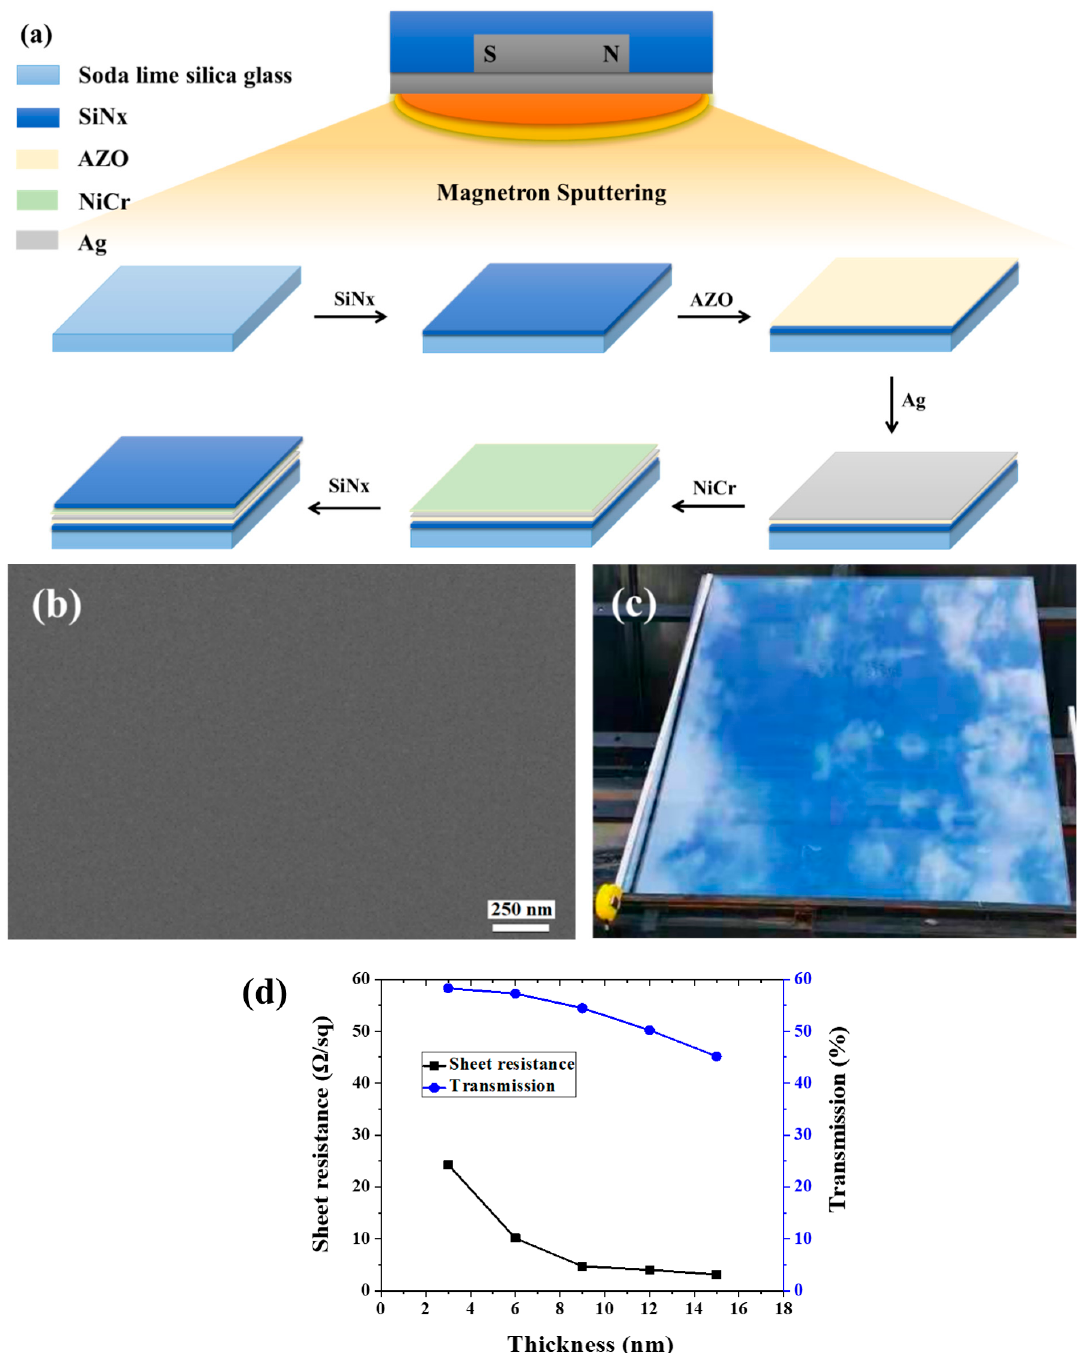
Figure 1. ( a ) Scheme of ultra-thin Ag conductive film (ACF) preparation procedure. ( b ) SEM image of ACF. ( c ) Optical photo of large-scale ACF samples deposited on the glass surface. ( d ) Sheet resistance and transmission of ACF with different thicknesses.